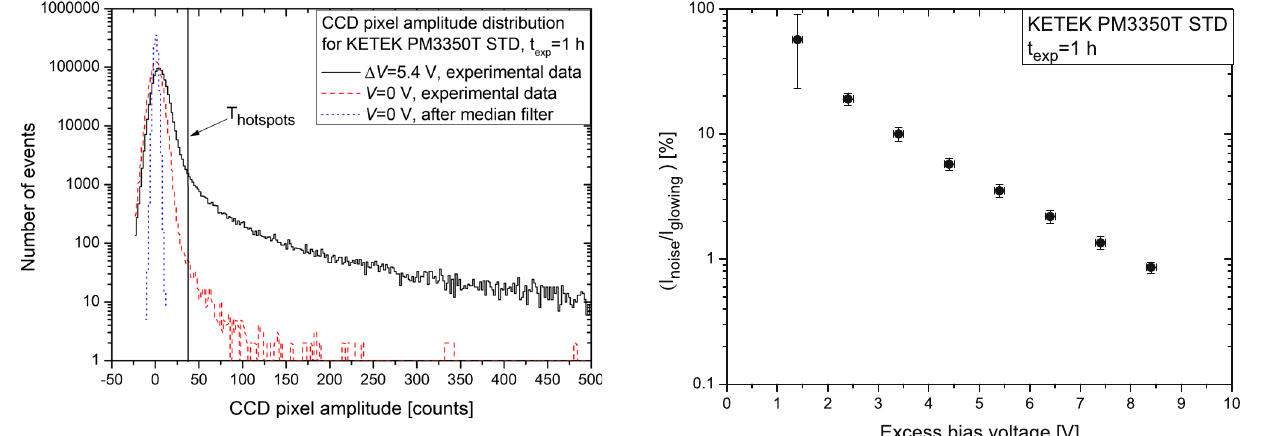
Fig. 6 Examples of CCD pixel amplitude distributions